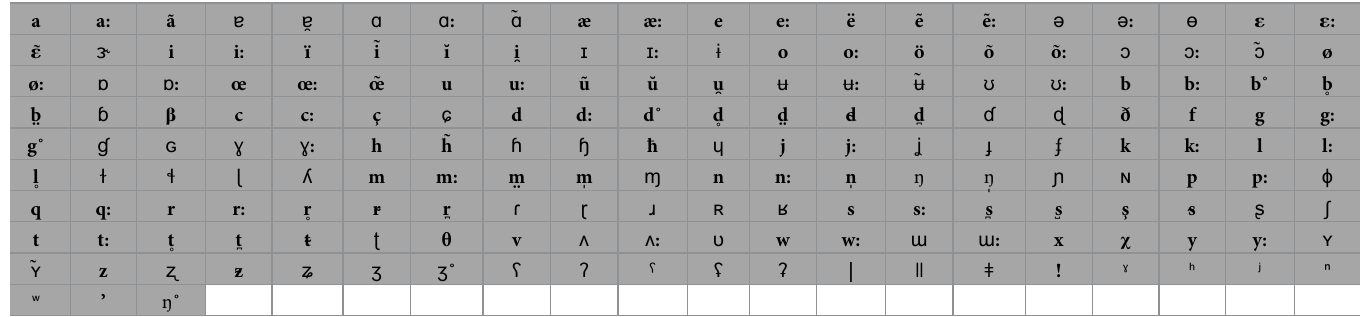
Table 3. Total set of